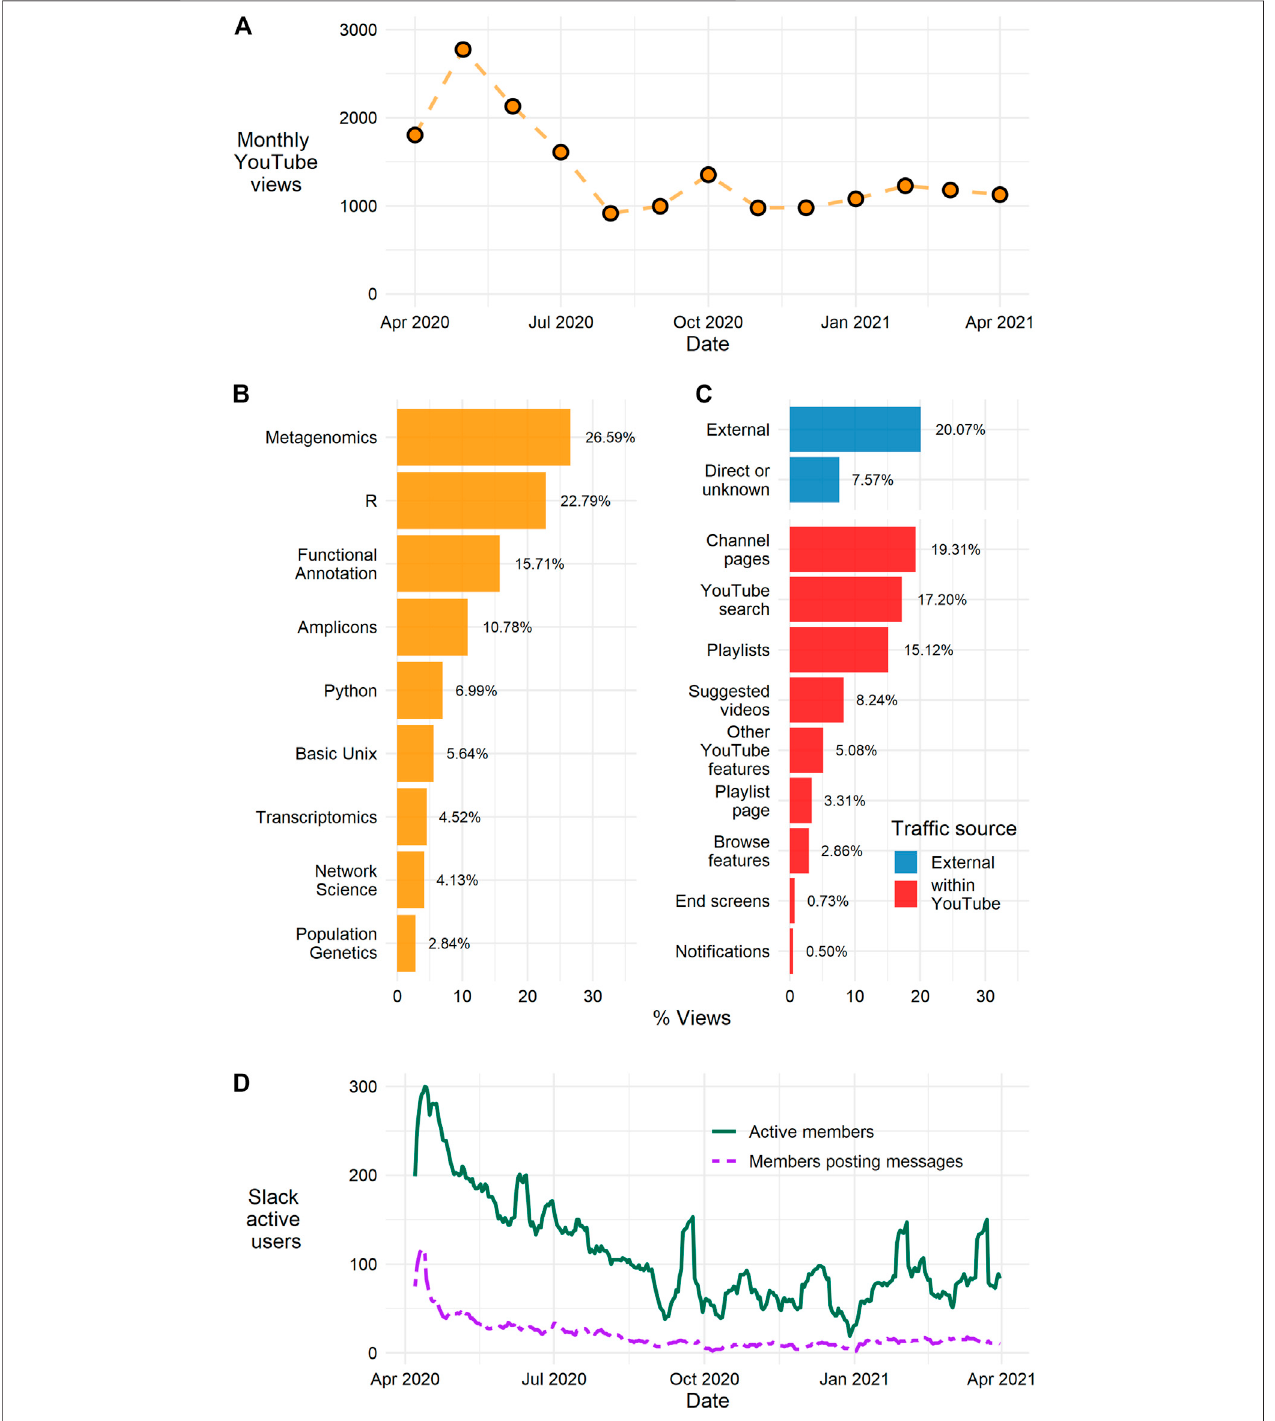
FIGURE 1 | Overview of the number of views of BVCN YouTube videos and Slack membership. (A) Monthly viewing fi gures for the BVCN YouTube channel; the total accumulated views for the channel is 16,325 views (accessed 29 April 2021), views per month peaked in May 2020 at 2774, and viewing numbers have fallen but stabilizedatanaverageofover1,000viewspermonthfromAugust2020topresent. (B) ThepercentageoftotalviewsfortheBVCNchannelsplitbysubjectplaylists;the MetagenomicsandRplaylistsarethe fi rstandsecondmostviewedplaylistsaccountingforalmosthalfofthetotalviewsfortheBVCNchannel. (C) Thepercentage of total views for the BVCN channel split by “ traf fi c source ” top bars (blue) indicate views came from sources external to YouTube, bottom bars (red) indicate views that originate within the YouTube website. The top four bars (External, Direct or unknown, Channel pages, YouTube search) are views that originate from “ searches with intent ” viewers actively searching for BVCN videos ? these account for 64% of total views. (D) The seven-day rolling average for Slack user activity; active members are thosewhousedtheSlackworkspaceinthelastsevendays(solidgreenline),andthenumberofusersthathavepostedmessagestotheworkspace(dashedpurpleline). Slack use peaked in April 2020 and stabilized at between 50 and 100 active users per month from September 2020.